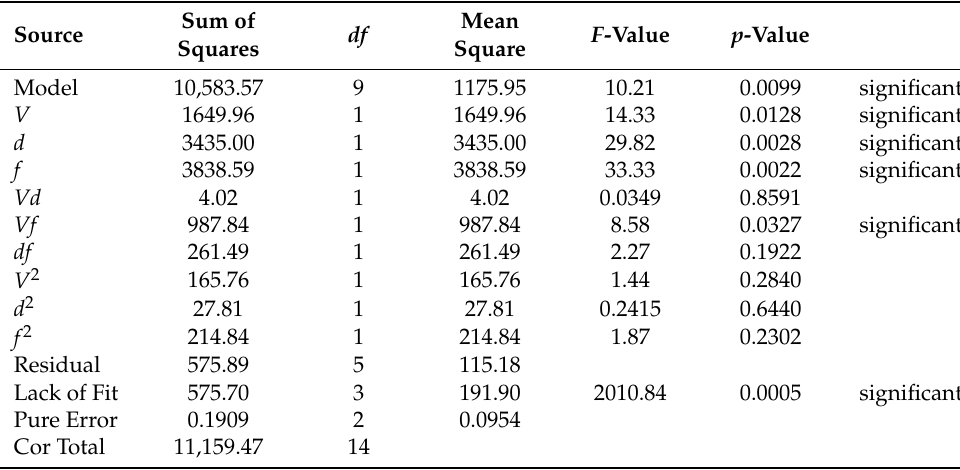
Table 10. The ANOVA table for power